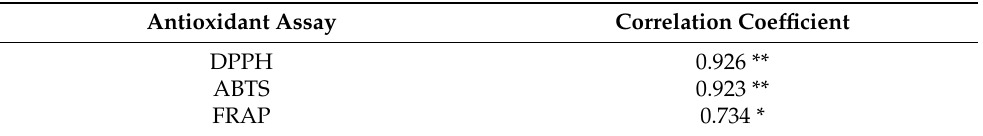
Table 1. Pearson correlation coefficient of the Apocynum total flavonoid content and antioxidant